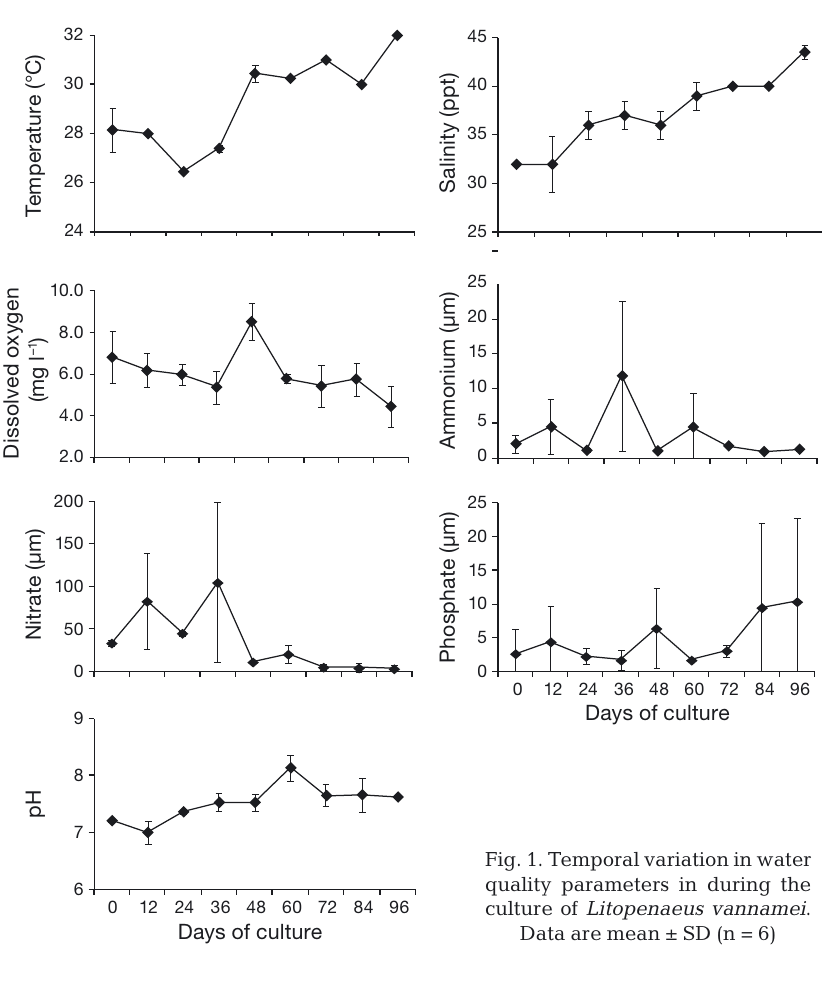
Fig. 1. Temporal variation in water quality parameters in during the culture of Litopenaeus vannamei . Data are mean ± SD (n =